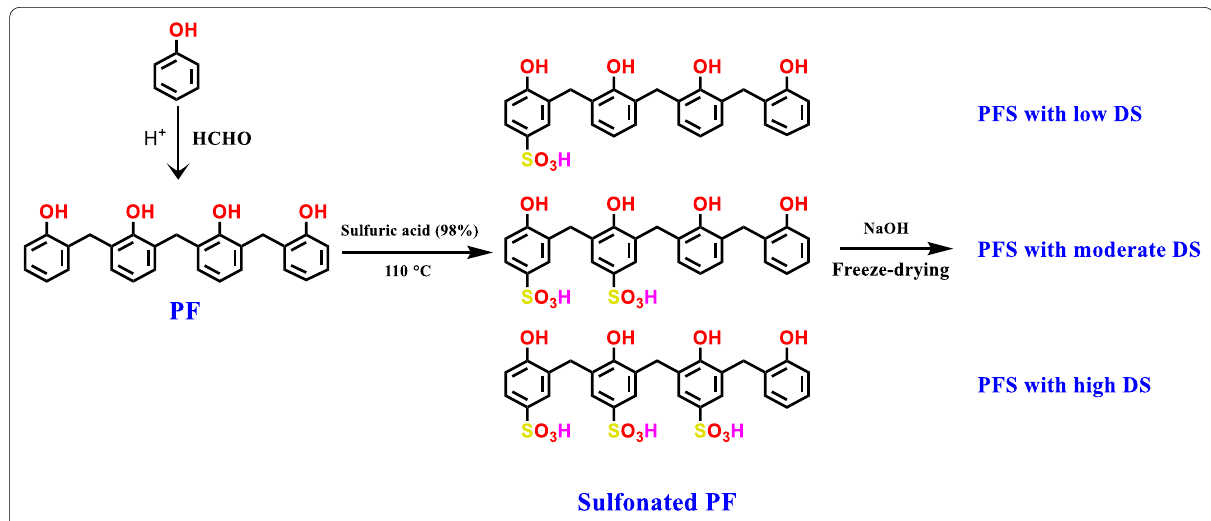
Fig. 1 Schematic of synthesis route of PFS. (PFs involve ortho and para PFs. Here, only the ortho PFs are